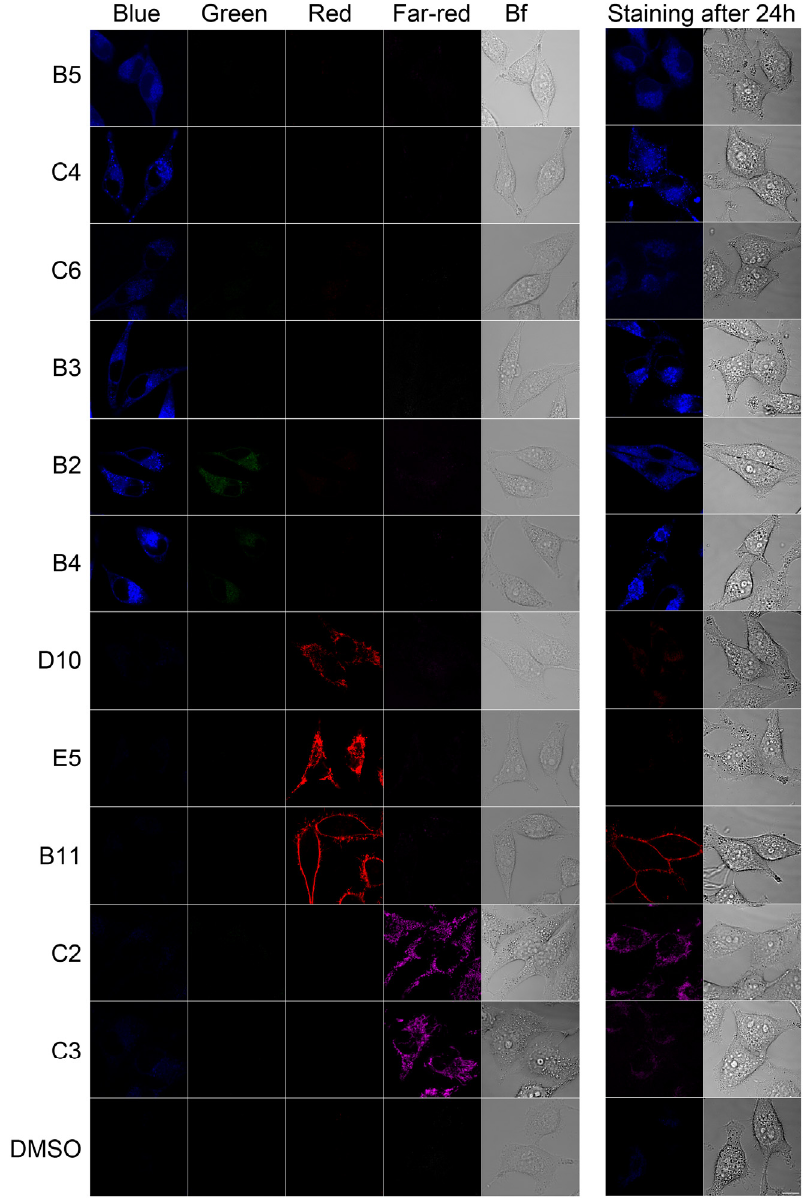
Figure 2. Fluorescence emission and intracellular localization of selected chemicals. Fluorescence emission of the tested chemicals (1 h at 37 °C, 10 µM each, except C2 which was 1 µM) were captured in four channels (blue, green, red and far-red) using 405, 488, 543 and 633 nm laser excitation. Fluorescence emissions were also captured after 1 day of incubation at 37 °C (staining after 24 h). Only the image of the brightest fluorescence color paired with the corresponding bright field image was shown for “Staining after 24h” images. Up to three times wider confocal aperture (pinhole) was used for taking “Staining after 24h” images. Control cells were treated with DMSO. Bf: Bright field imaging. Scale bar 10